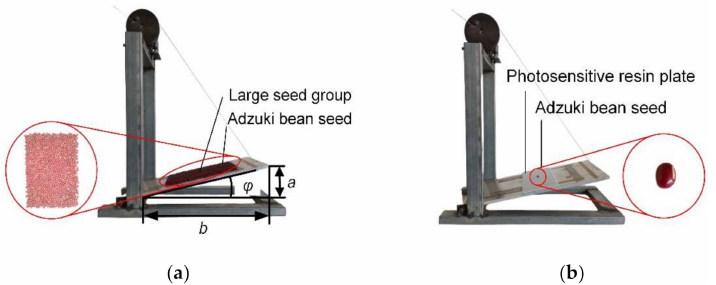
Figure 5. Measurement of coefficient of rolling friction. ( a ) coefficient of rolling friction of ABS–ABS; ( b ) coefficient of rolling friction of